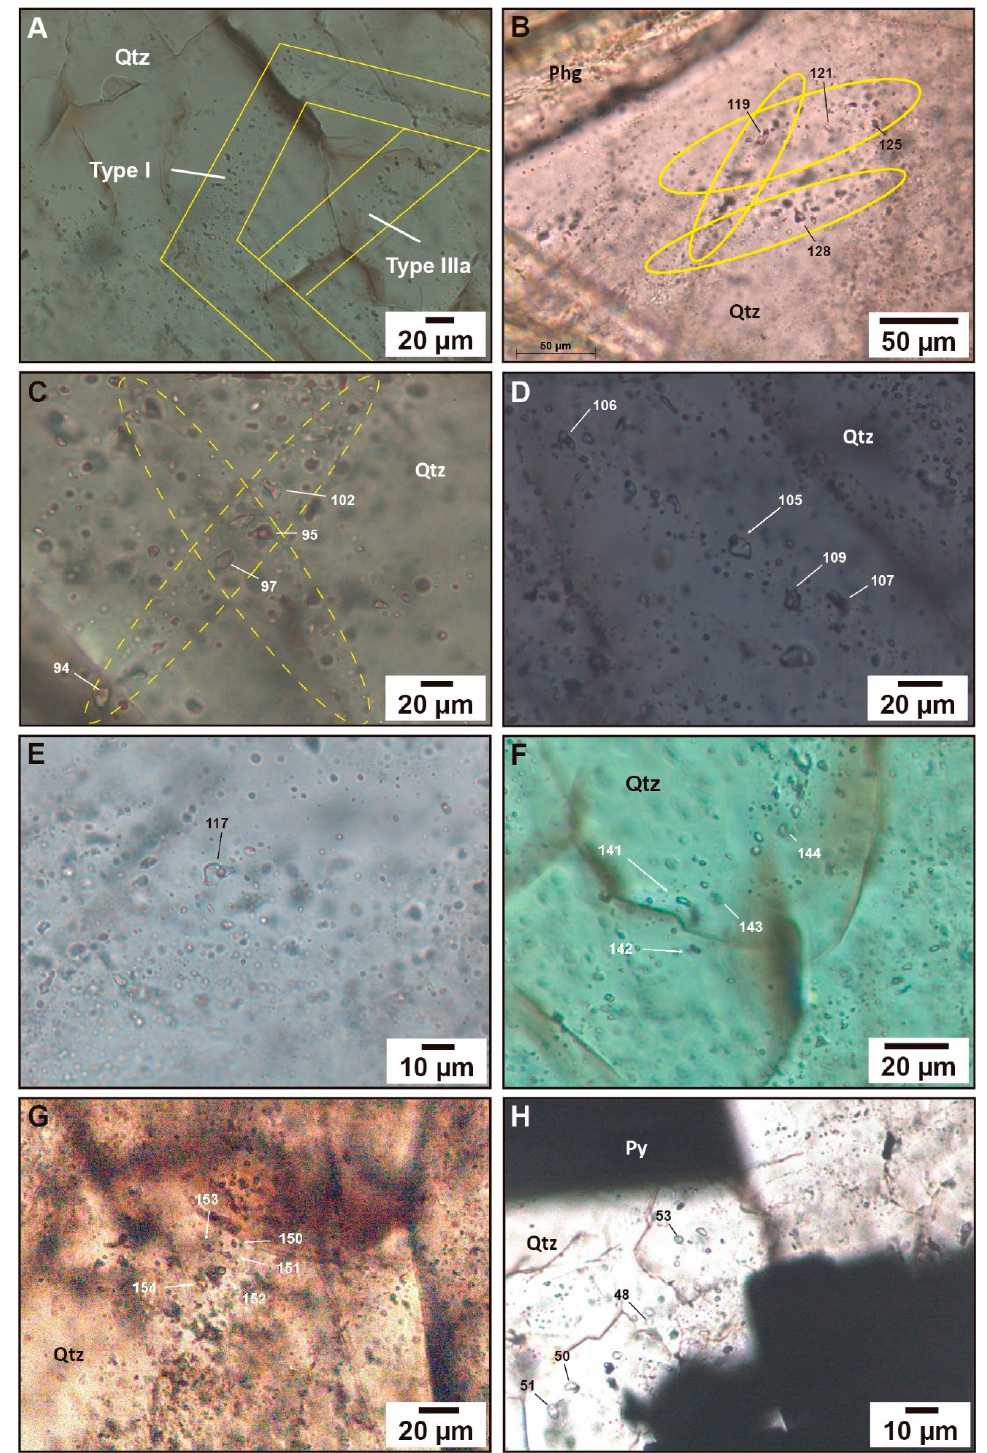
Figure 15. Fluid inclusion petrography of gold mineralisation at the Passa Três gold deposit (Barreiro zone): ( A ) Primary H 2 O-CO 2 -NaCl (type I) in growth zones in magmatic quartz and secondary type IIIa inclusions as a trail, red granite sample; ( B ) Type II (H 2 O-CO 2 -NaCl) fluid inclusions in quartz 1 from a mineralised vein; ( C ) Type II (H 2 O-CO 2 -NaCl) fluid inclusions showing different shapes and vapor/liquid ratio in a granite sample; ( D ) Type II (H 2 O-CO 2 -NaCl) fluid inclusions showing